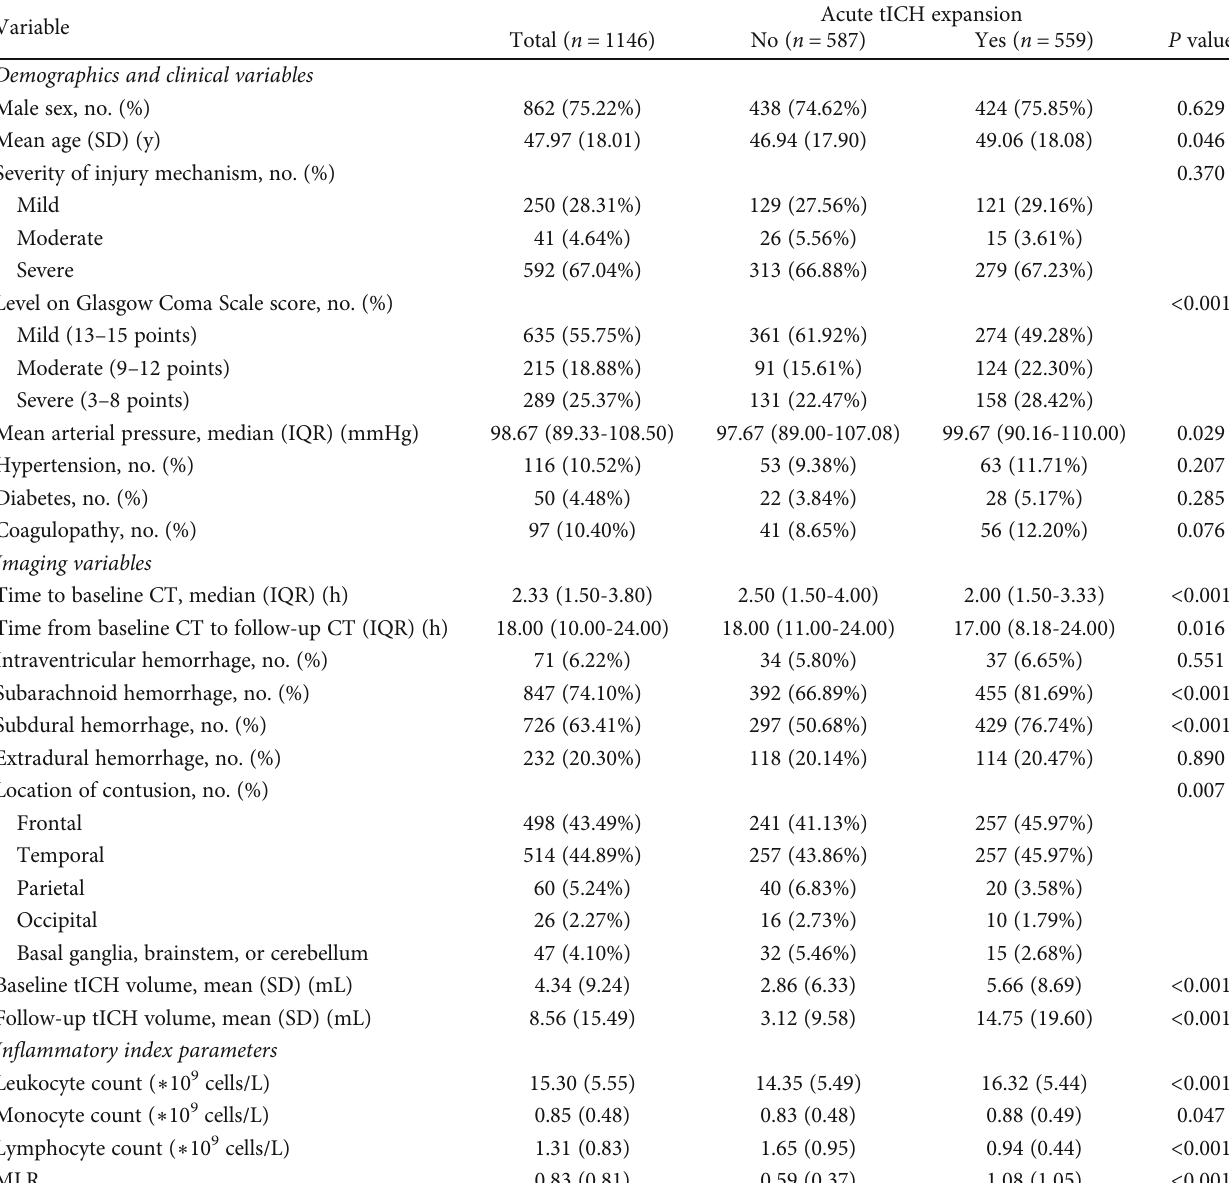
Table 1: Baseline characteristics according to acute tICH